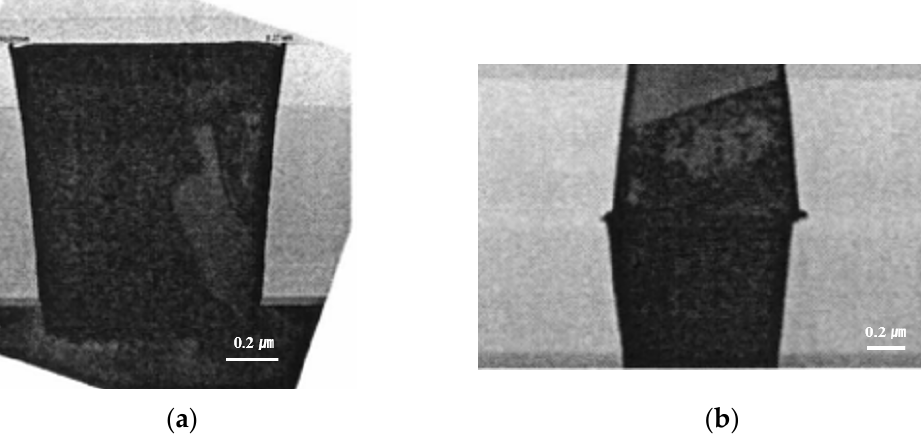
Figure 3. ( a ) The cross-sectional image of a fabricated wafer before bonding. ( b ) The cross-sectional image of the bonded wafer after completion of the annealing process including copper via and pad.